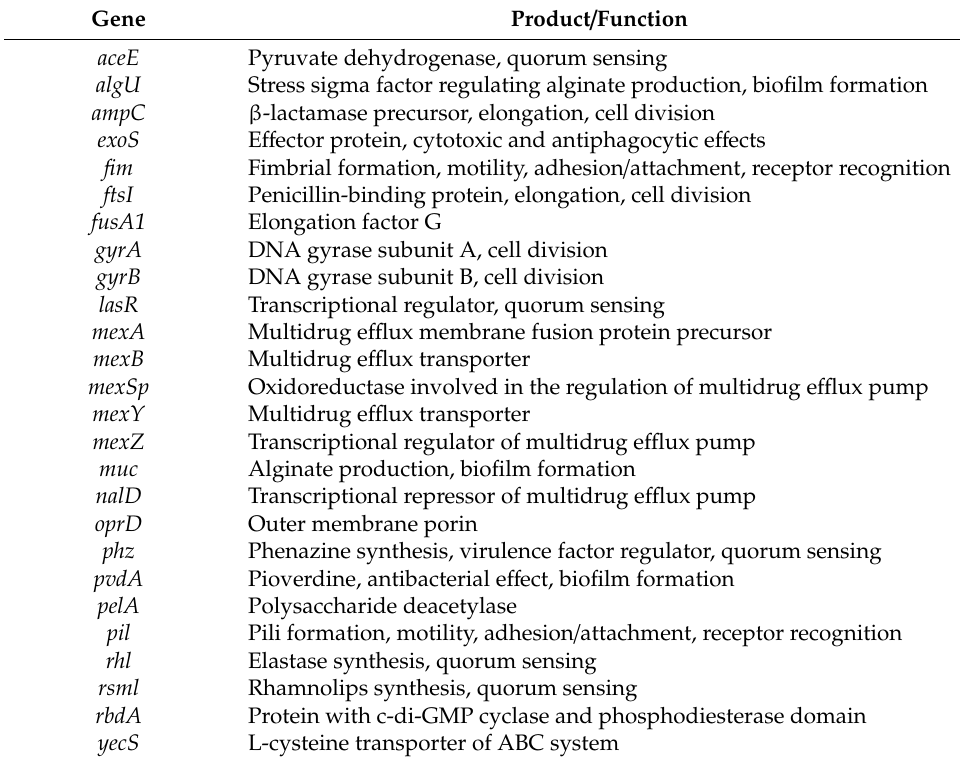
Table 1. Examples of adaptative genes facilitating the survival of P. aeruginosa isolates (modified from Marvig-2015)